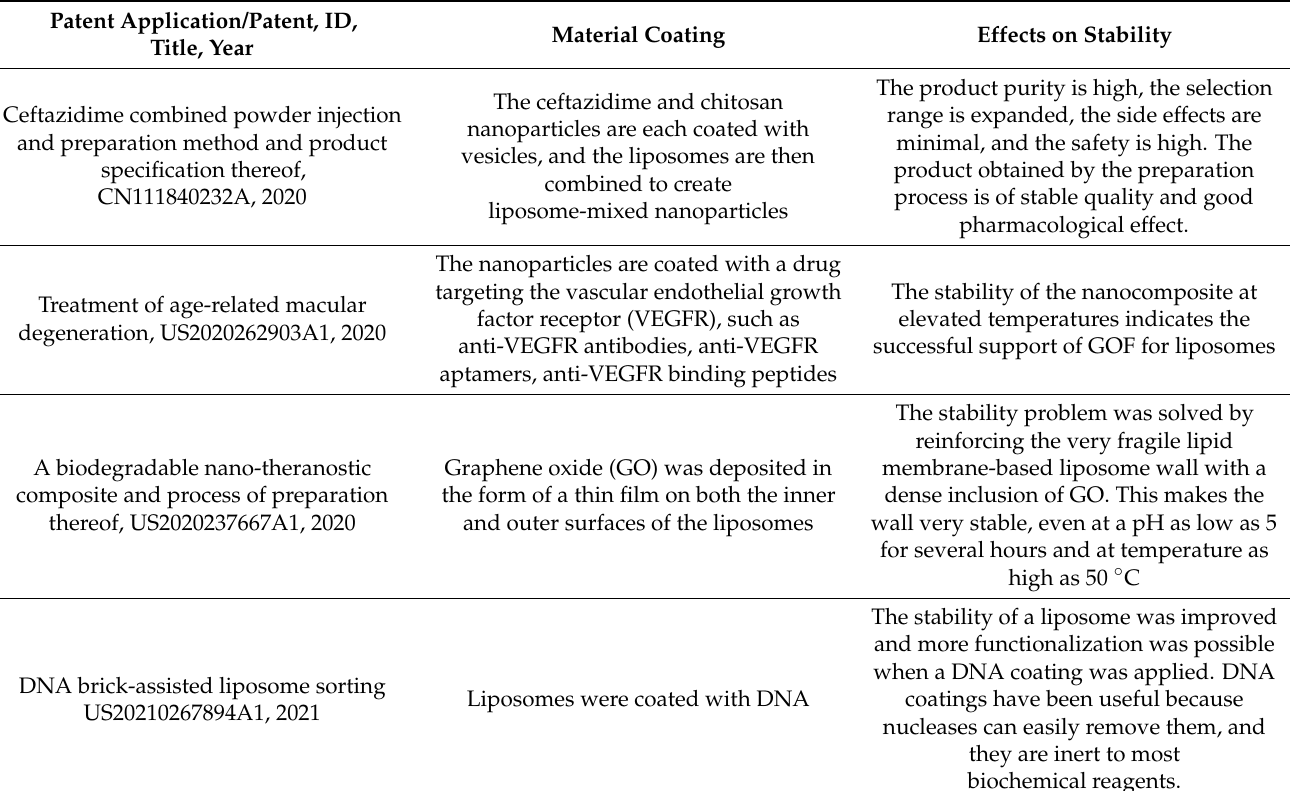
Table 6. Recent patent applications and patents on coated